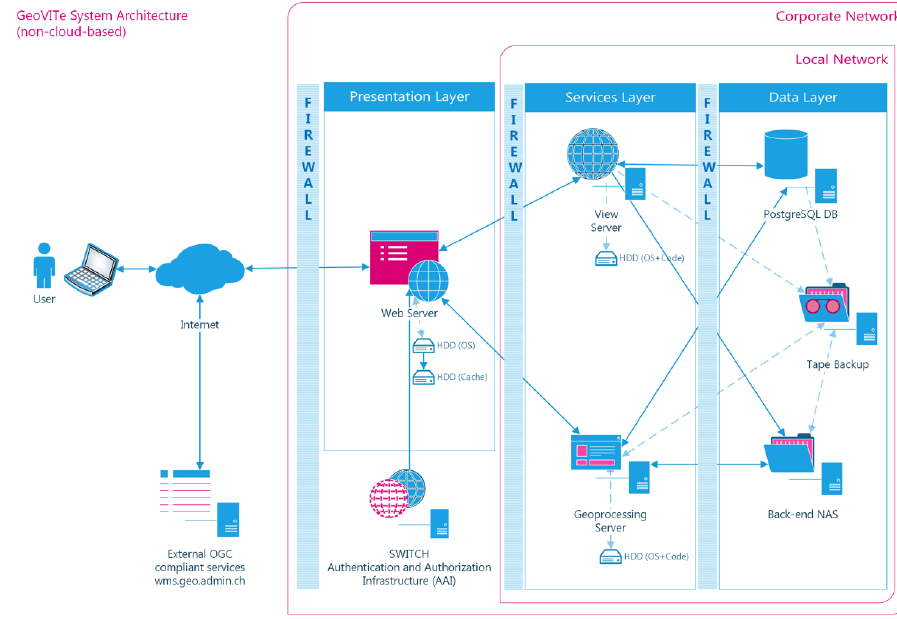
Figure 3. The traditional system architecture of the GeoVITe geoportal.